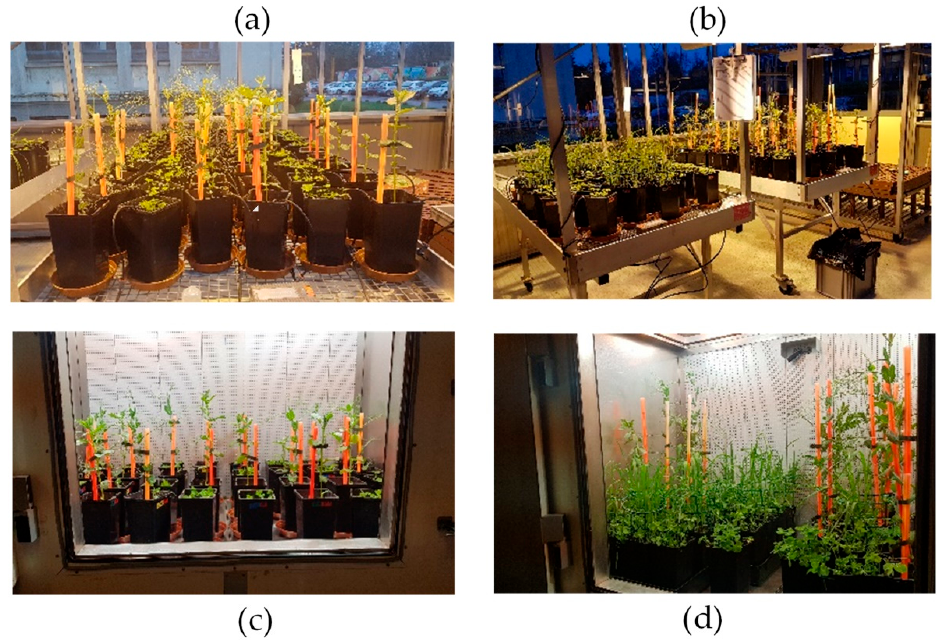
Figure 1. ( a,b ) Plant growing in greenhouse; ( c , d ) plants in the growing chamber.